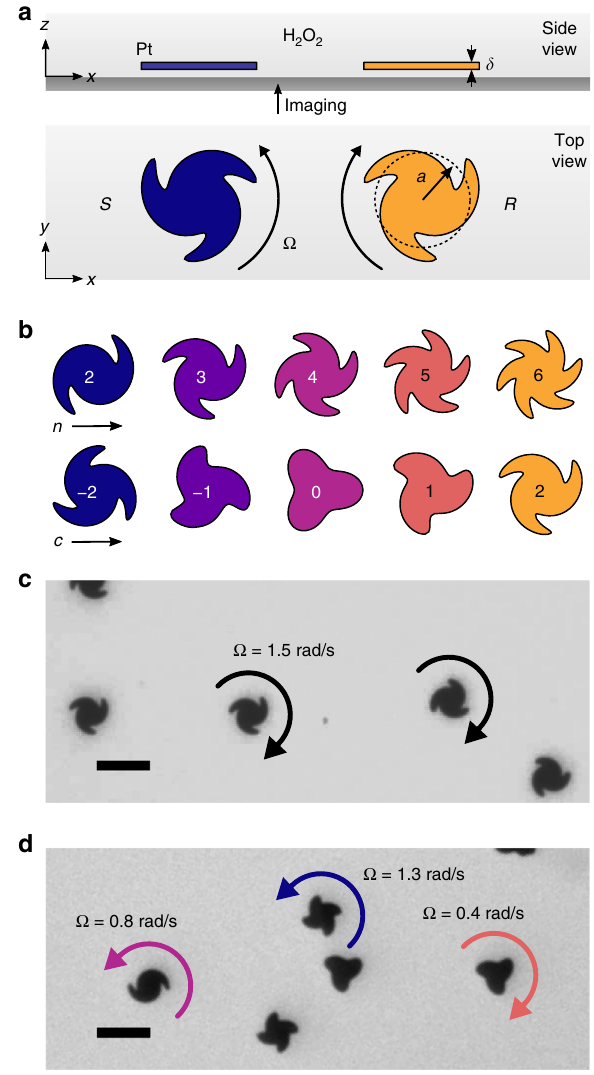
Fig. 1 Shape-directed particle rotation. a Schematic illustration of two platinum disks ( a = 5.77 μ m, δ = 100 nm) of opposite handedness rotating above a glass substrate in a solution of hydrogen peroxide. b The parametric particle shape depends on the number of fi ns n and the fi n asymmetry c . c Optical microscope image of particles with n = 3 and c = 2 rotating clockwise at a speed of Ω = 1.5 ± 0.2 rad s − 1 in a 10 wt% solution of hydrogen peroxide (see Supplementary Movie 1). d Optical microscope image of multiple types of particles rotating in different directions and at different rates in a common environment of 10 wt% hydrogen peroxide (see Supplementary Movie 2). Scale bars are 20 μ